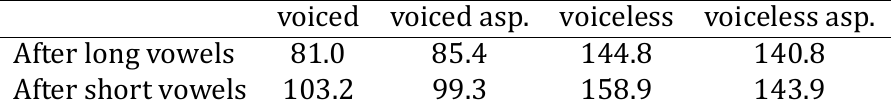
Table 5: Hindi stop closure durations (ms)